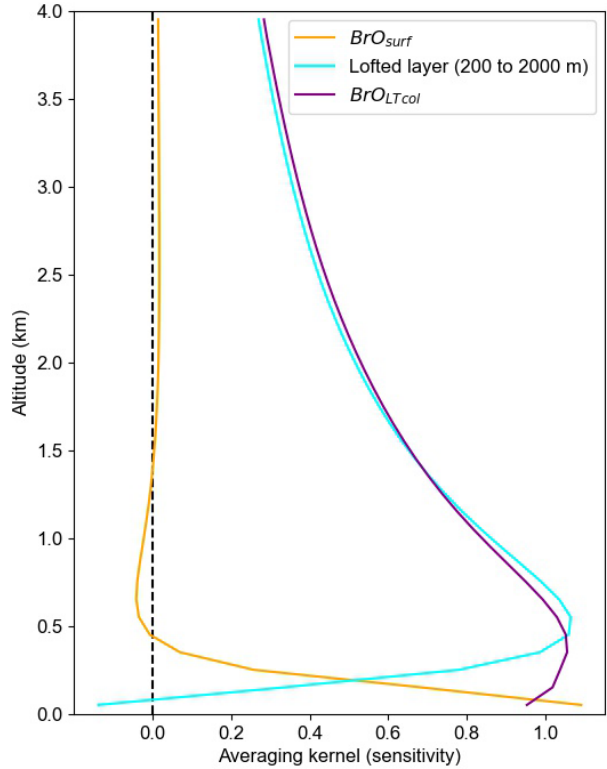
Figure 3. Averaging kernels showing the sensitivity of retrieved BrO LTcol and retrieved BrO surf to BrO at a range of altitudes. Each line represents a row of the averaging kernel matrix. BrO surf is the column from the surface to 200m, and BrO LTcol is the column up to